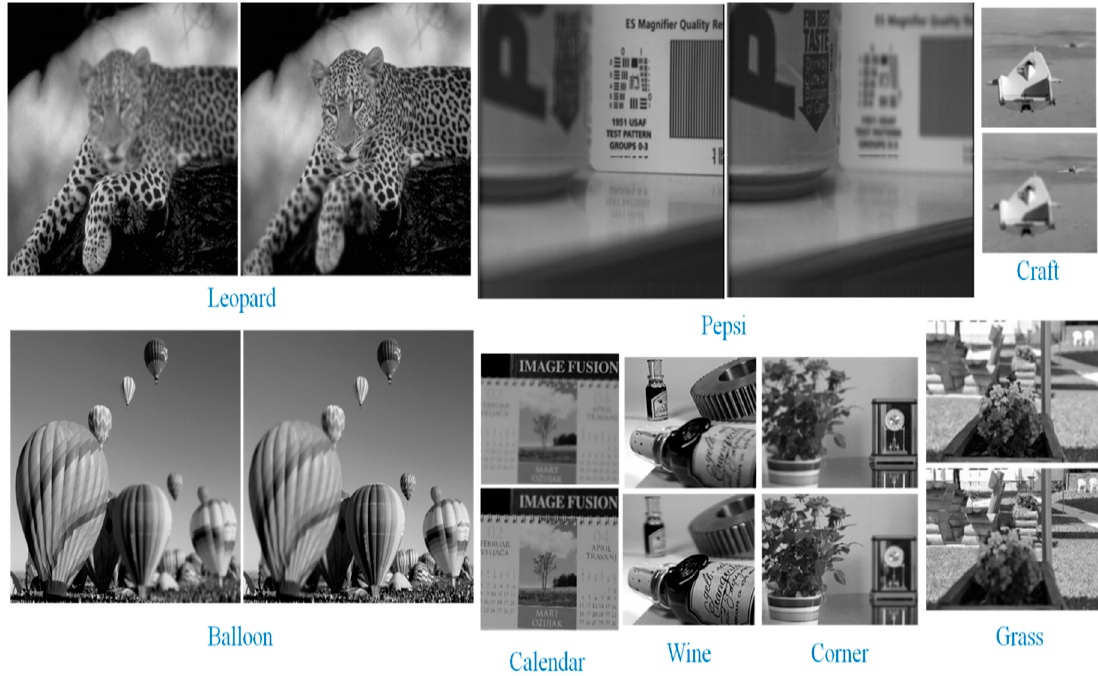
Figure 17. A few pairs of multi-focus images.